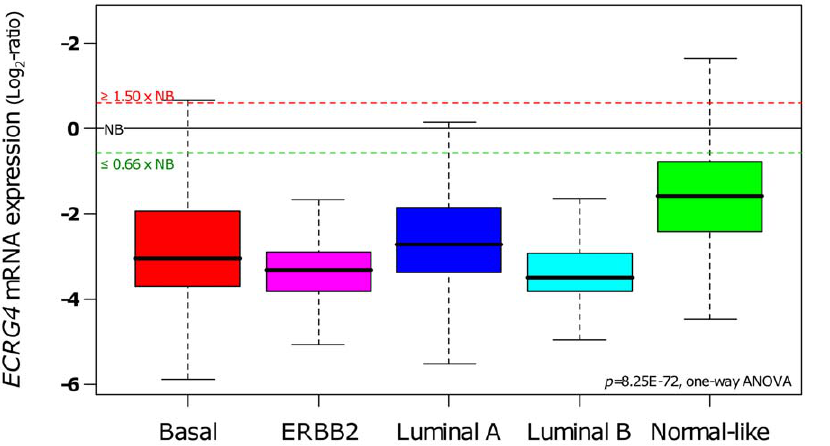
Figure 2. mRNA expression of ECRG4 according to breast cancer molecular subtypes. ECRG4 expression across 1,387 breast cancer samples was examined according to molecular subtypes. Box plots of ECRG4 expression are shown according to basal, ERBB2, luminal A, luminal B, and normal-like subtypes. Expression values are NB-centered. The horizontal black line represents the level of expression of ECRG4 in normal breast (NB) tissue. Differences in ECRG4 expression levels between the subtypes were tested for significance using one-way ANOVA. For each box plot, median and ranges are indicated.